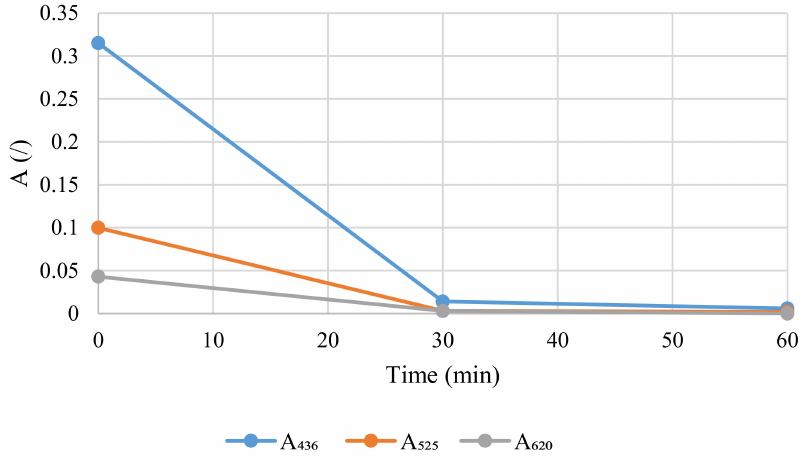
Figure 3. Changes in absorbance (A) vs. the time of